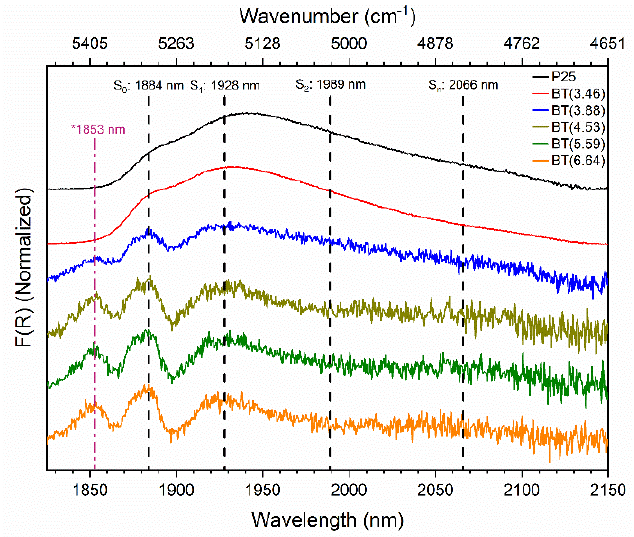
Figure 5. Normalized near-infrared spectra of blue titania samples in the region that provides infor- mation about the interaction of the partially reduced TiO 2 surface with physisorbed water mole- cules.